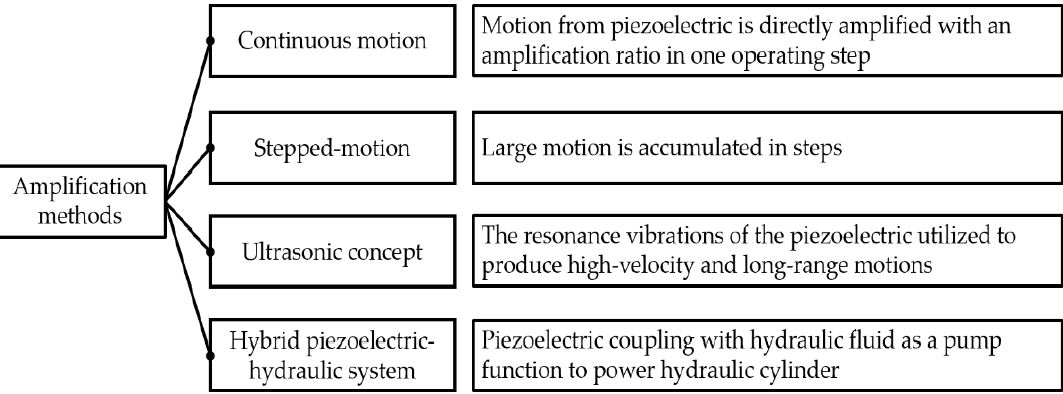
Figure 5. Summary of amplification methods.